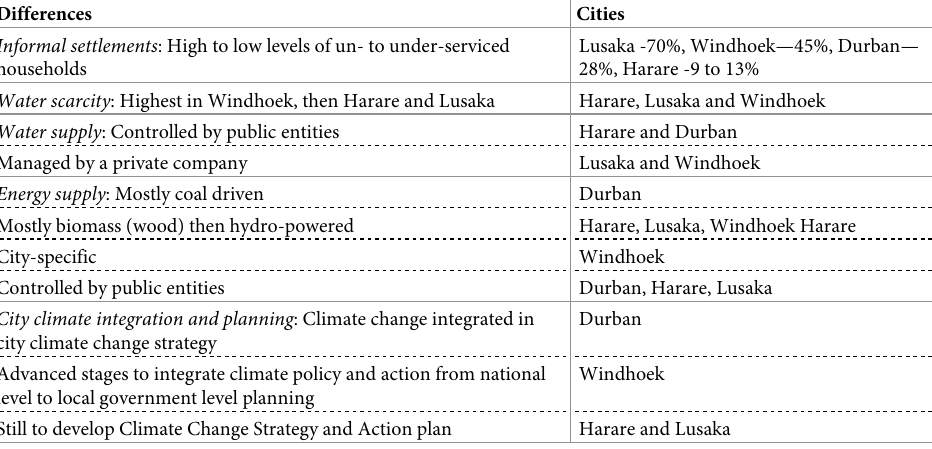
Table 4. Differences across the study